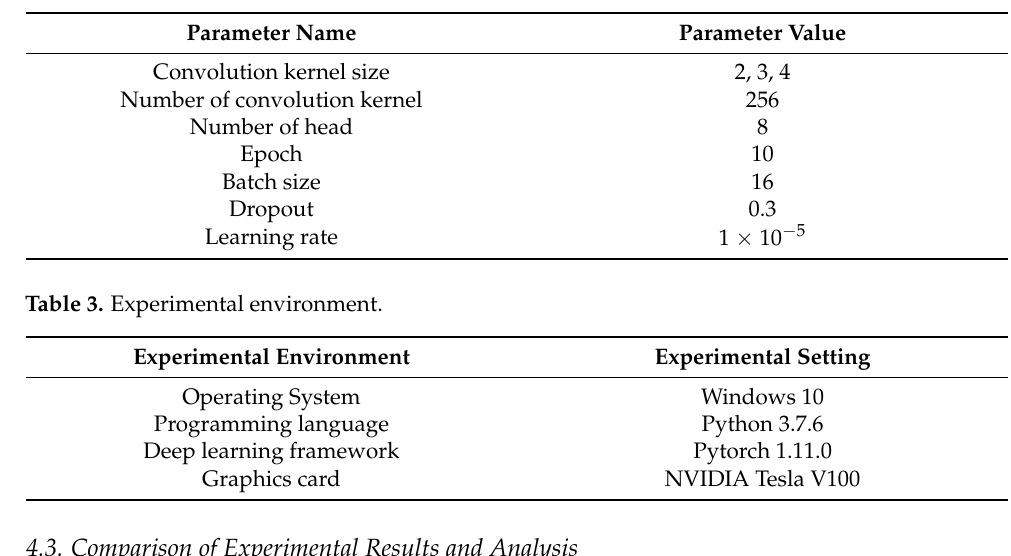
Table 2. Experimental parameter setting.